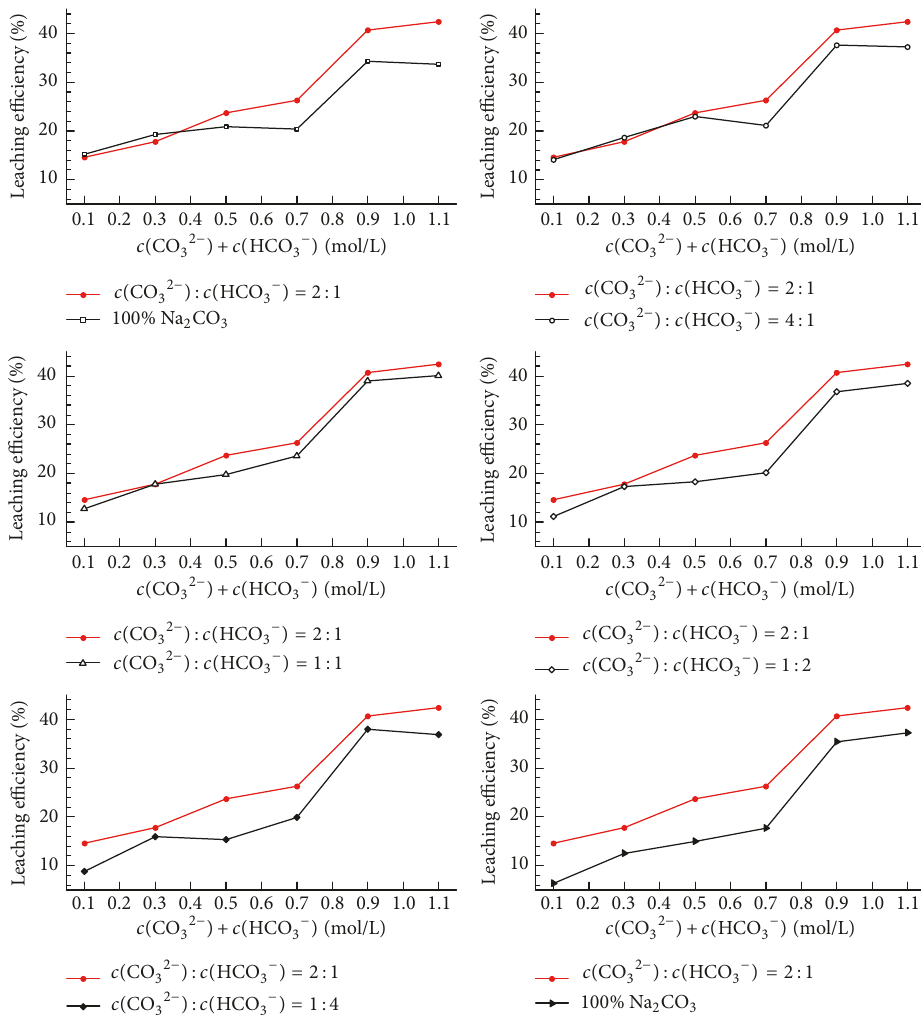
Figure 2: The leaching efficiency at various leaching agent concentrations and mixture ratios.